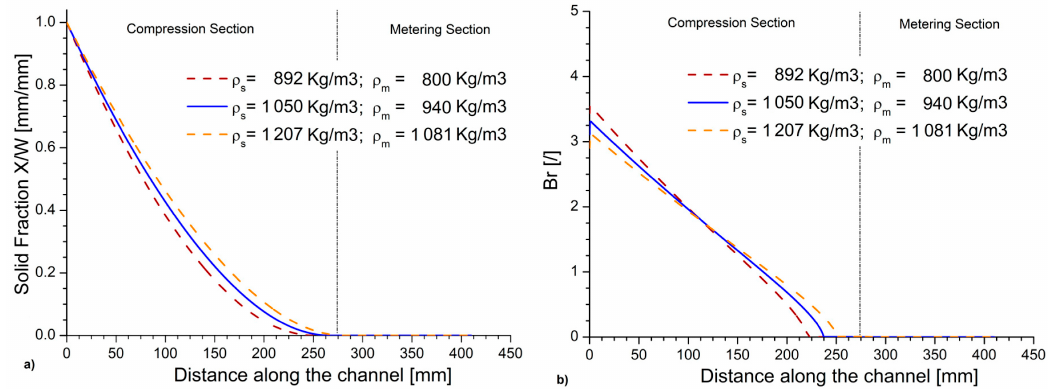
Figure11. ( a )Meltingprofile; and( b )Brinkmannumberfordi ff erentpolymersoliddensitiesconsidering otherwise the micro-extrusion settings and material parameters of Table 1 (Column 2). Blue (reference) lines as in Figure